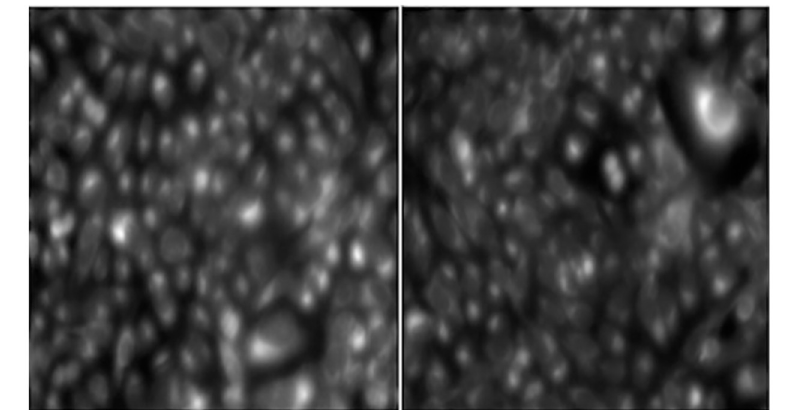
Fig 2. Plate 24277, well A13, containing DMSO, is